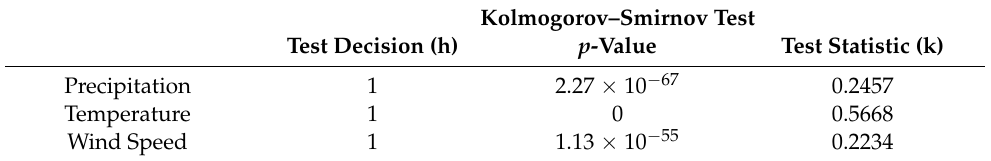
Figure 4. Relative frequency of monthly precipitation, temperature, and wind speed for months ( a ) without fire, ( b ) minor fire, and ( c ) major fire over the historical period (1986–2015). Table 1. The results of Kolmogorov–Smirnov